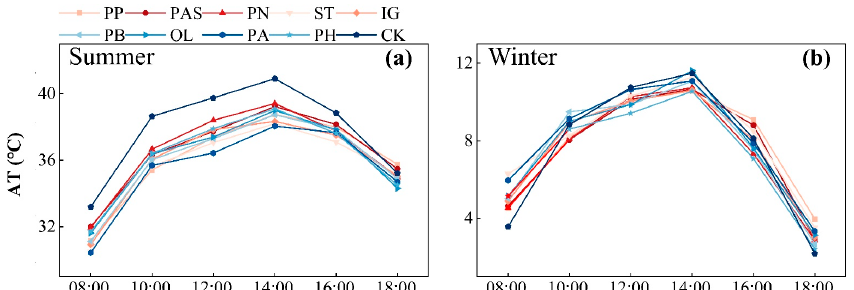
Figure 2. The diurnal variation in the AT of the different communities in summer ( a ) and winter ( b ).